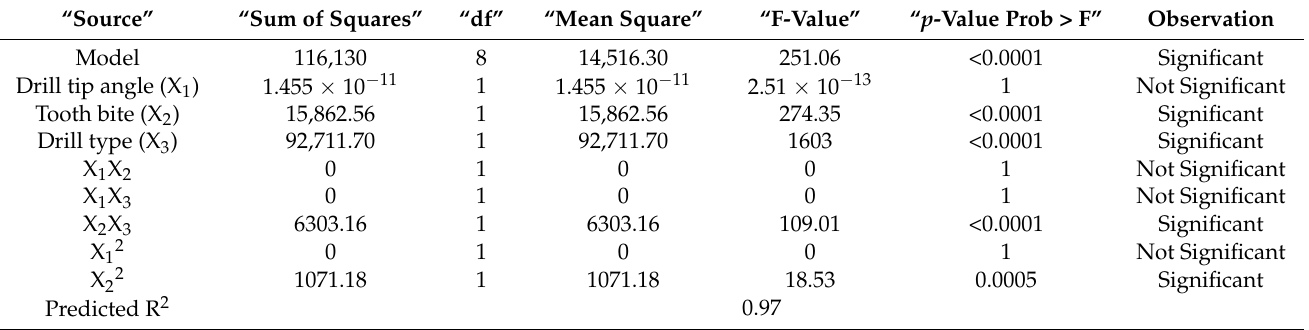
Table 7. Analysis of variance results for the quadratic equation in the case of thrust force.